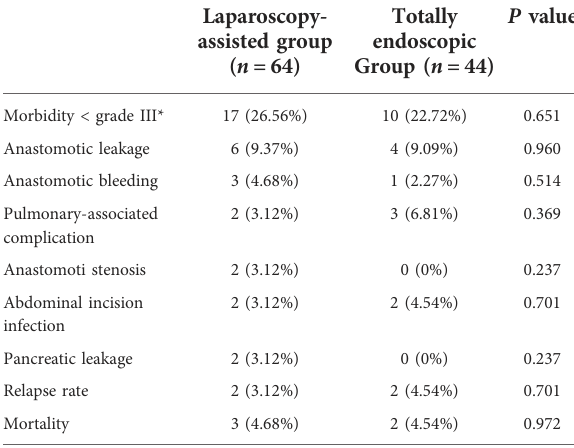
TABLE 6 postoperative safety index. TABLE 5 postoperative pathological